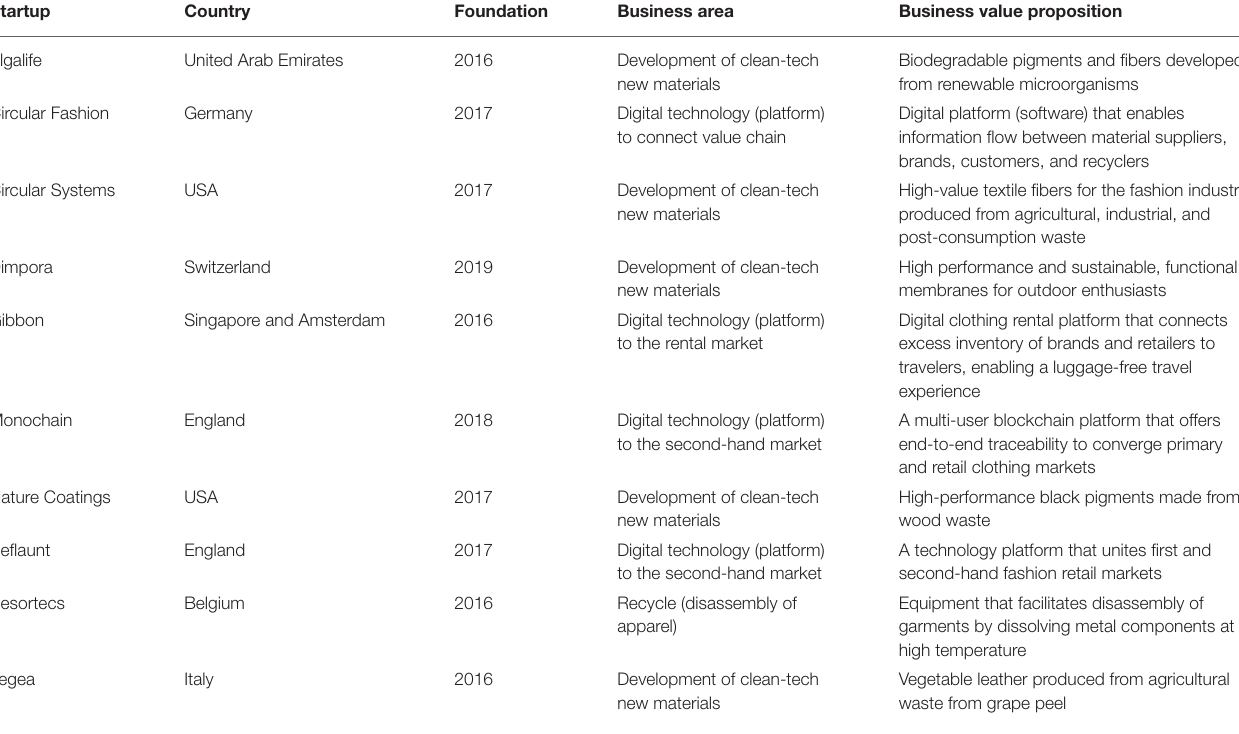
TABLE 1 | Fashion startups analyzed in the